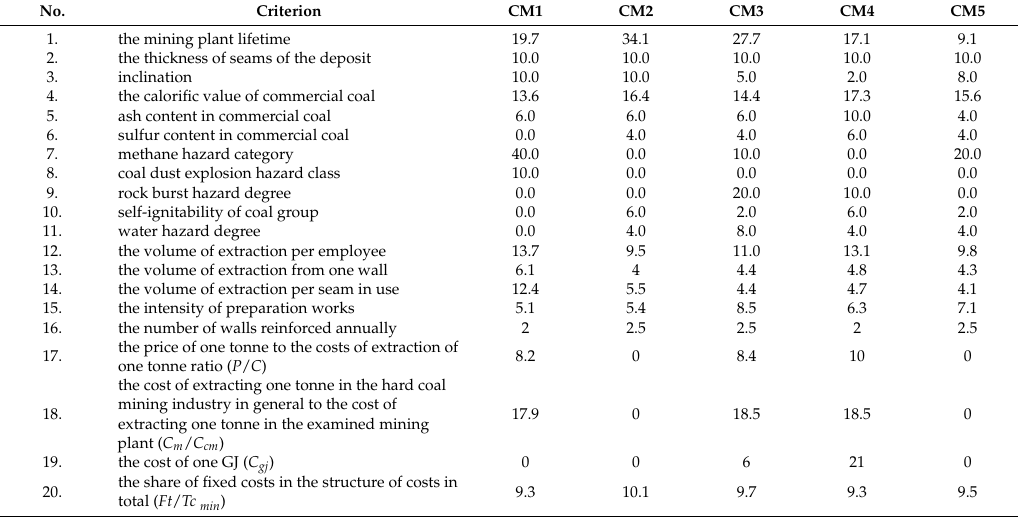
Table 5. The assessment of the given developmental criteria in the examined hard coal mines in 2011. No. Criterion